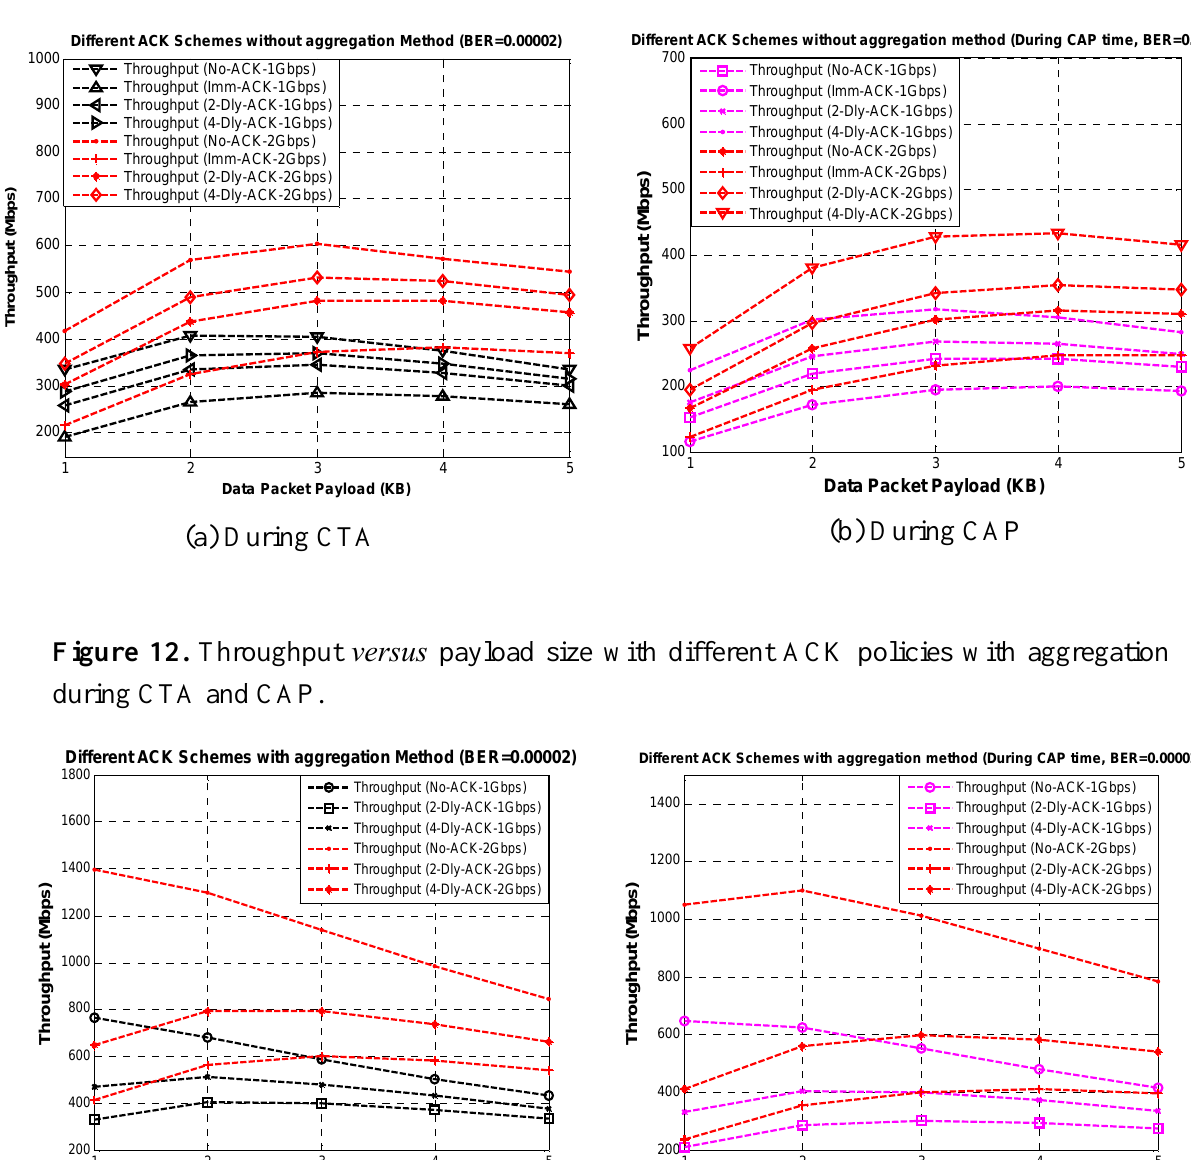
Figure 11. Throughput versus payload size with different ACK policies without aggregation during CTA and CAP.